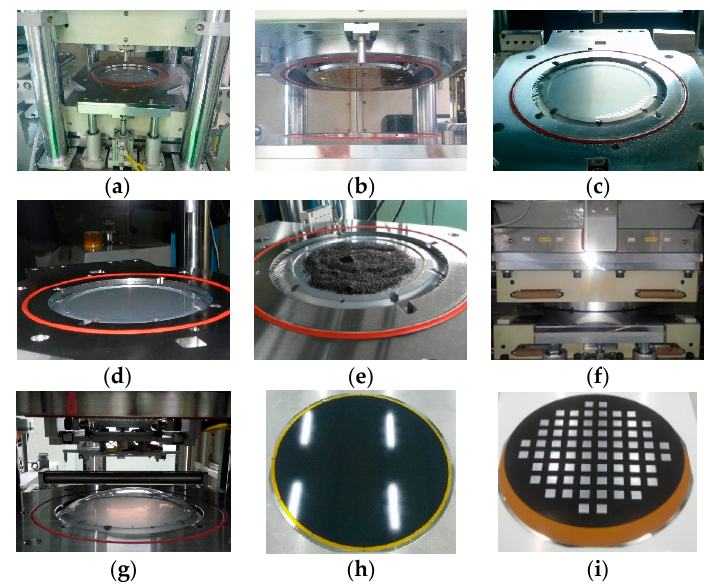
Figure 7. Experimental procedure of the compression molding process: ( a ) release film loading; ( b ) substrate loading; ( c ) release film clamp; ( d ) release film suction; ( e ) EMC loading; ( f ) mold pressing; ( g ) mold opening; ( h ) substrate unloading; ( i ) debonding.